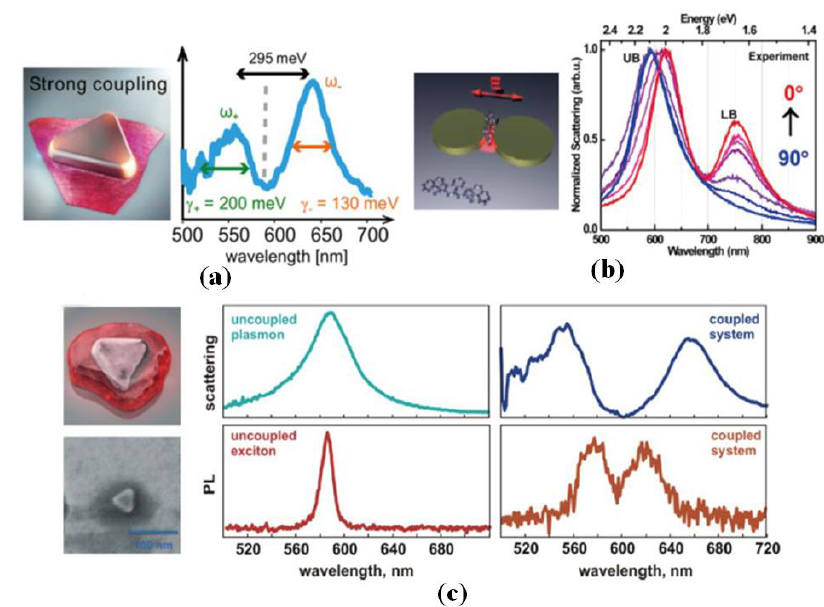
Figure 12. ( a ) SEM image of the prism and scattering spectrum of single nanoprism strongly coupled to J-aggregates [77]. ( b ) Structure diagram between J-aggregate excitons and single plasmonic dimers and polarized scattering spectra of plexcitonic dimer with detected polarization di ff erent angles [79]. ( c ) SEM images of the nanoparticles imaged on top of Au surface to visualize J-aggregate shell and the scattering spectums of uncoupled and coupled system [78].